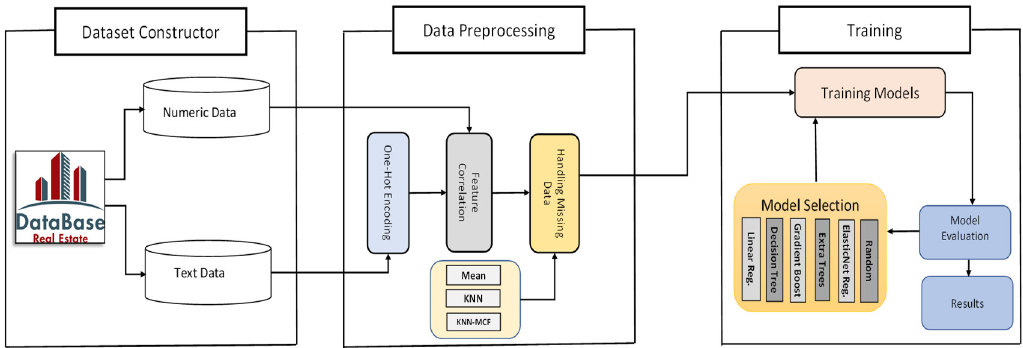
Figure 1. Optimized K-nearest neighbor (KNN) algorithm: KNN-based most correlated features.